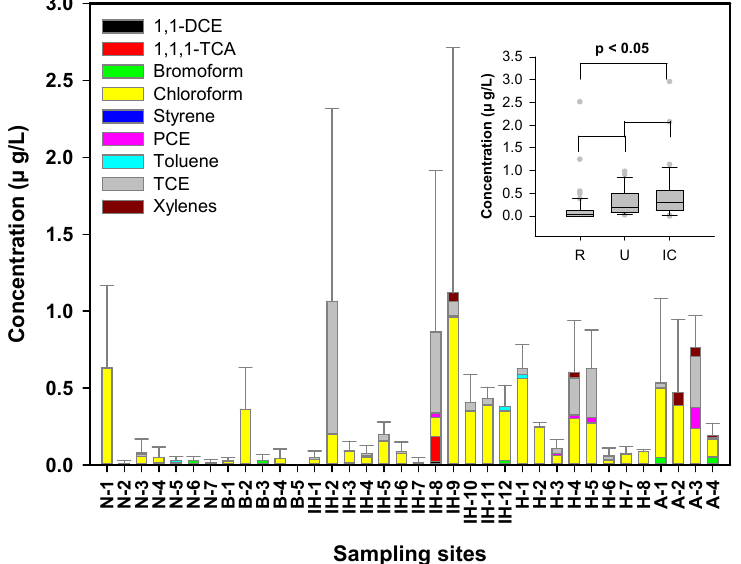
Figure 5. Distributions of VOC concentrations. Xylenes include m ‐ , o ‐ , and p ‐ isomers of xylene; undetected naphthalene and vinyl chloride were excluded; sample size ( n ) = 108.